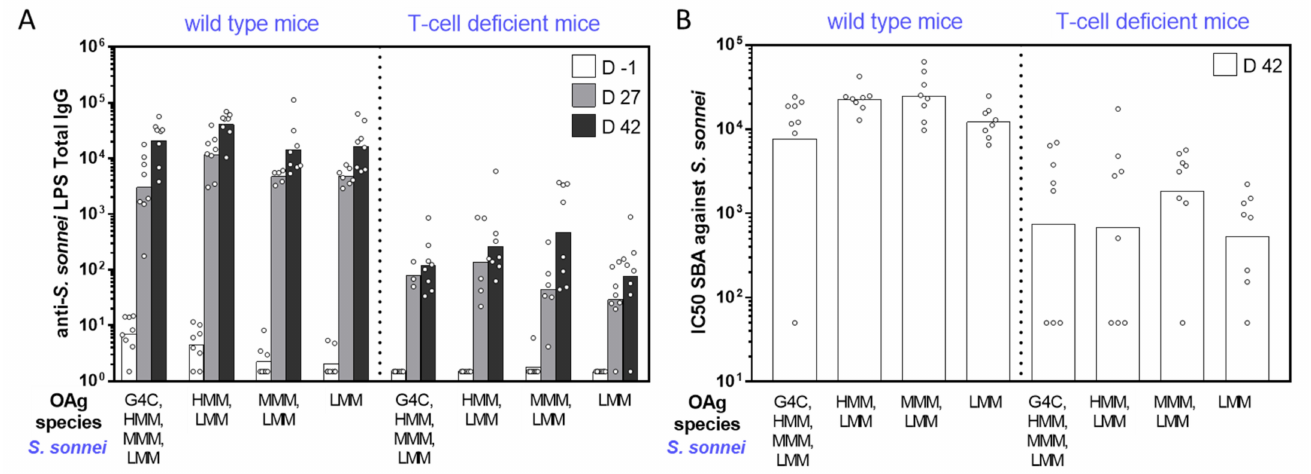
Figure 2. Immunogenicity in mice of S. sonnei GMMA differing for OAg length. Eight wild-type (CD1) and T-cell-deficient mice (nude CD1) per group were subcutaneously immunized on days 0 and 28, with 0.5 µ g OAg dose. ( A ) Summary graphs of anti-LPS specific IgG reporting individual antibody levels (dots) and geometric mean with 95% confidence interval (bars). ( B ) Summary graph of serum bactericidal activity (SBA) titers against S. sonnei reporting individual IC50 levels (dots) and geometric mean